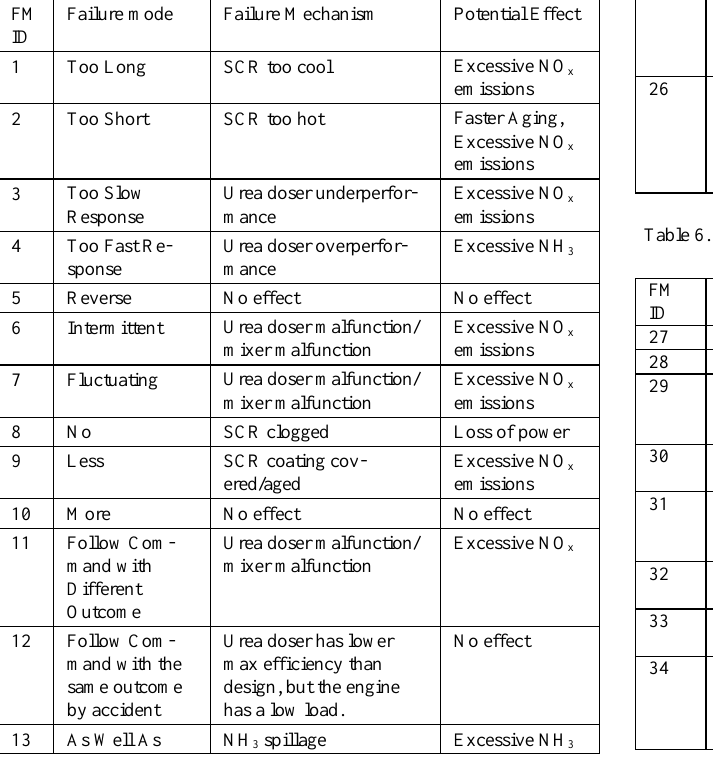
Table 4. FMEA of SCR element, function neutralise NO x